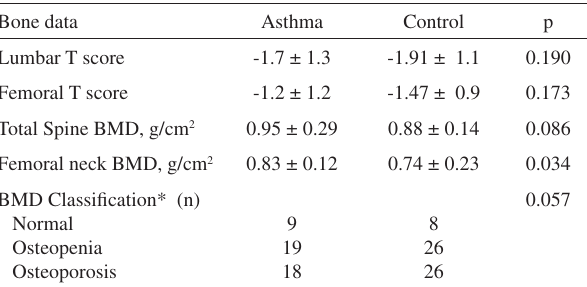
Table 3 - Bone mineral densitometer results and osteoporosis classifications Bone data